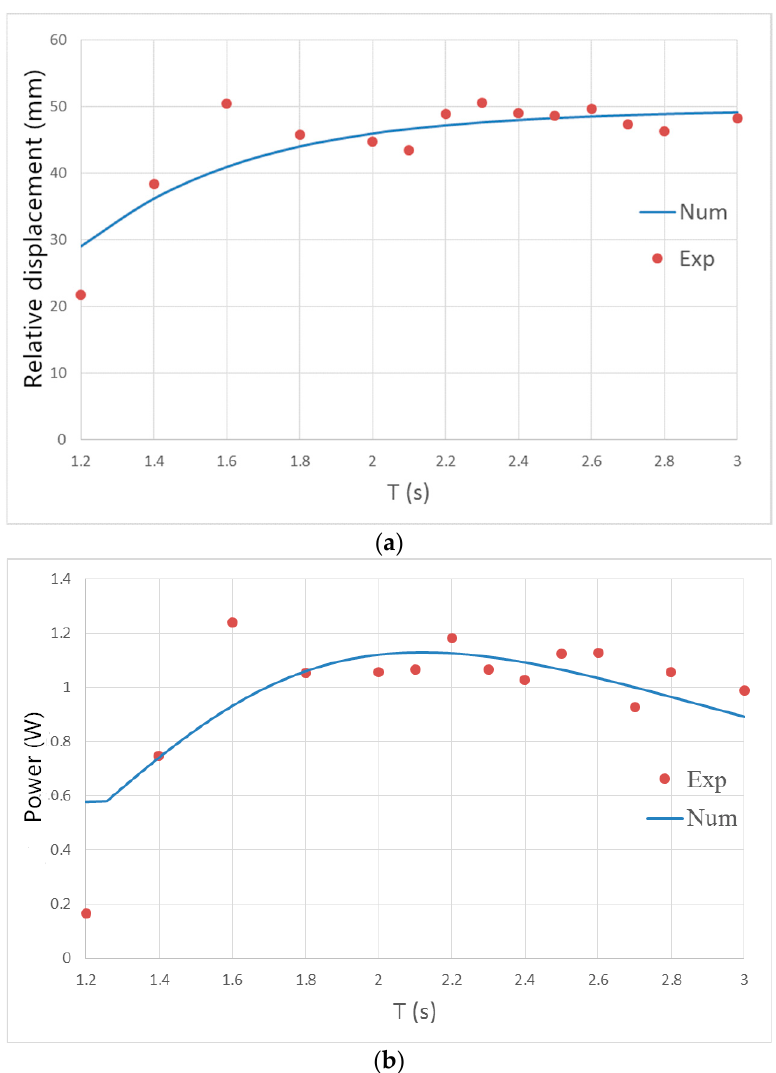
Figure 9. The motion curve and power curve in the different sea state: the continuous curve represents the numerical results obtained with a potential flow approach, and the points represent the experimental results. ( a ) Relative displacement (mm); ( b ) power output. Table 4. Calculation error for oscillatory movement.